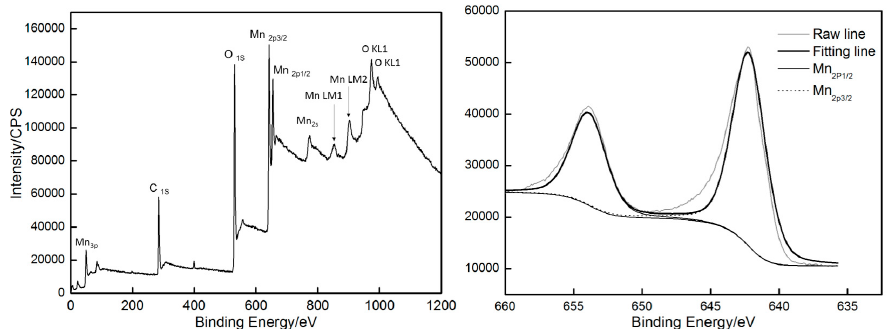
Figure 13. The survey and Mn 2p XPS spectrum of the deposit (60 s).